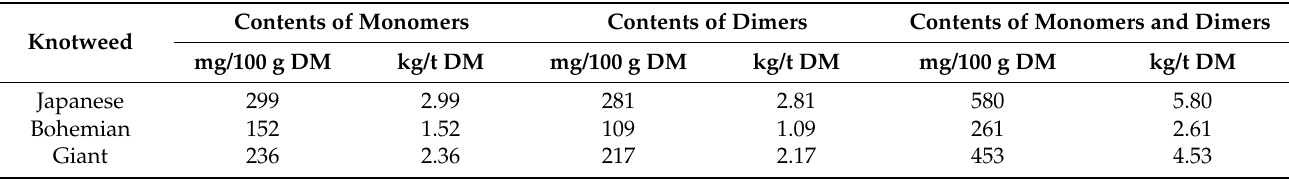
Table 2. Contents of monomers and dimers in rhizomes of Japanese, Bohemian and giant knotweed, expressed per dry mass (DM) of the plant material and quantified based on the ( − )-epicatechin and procyanidin B2 calibration curves, respectively.